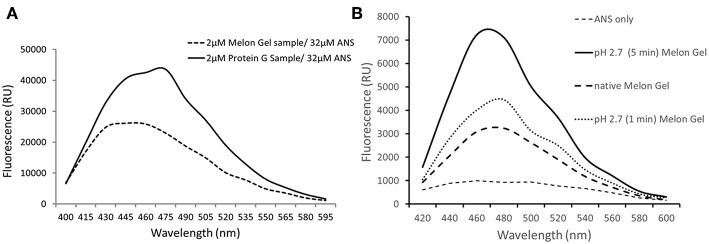
(A) Emission spectra of 32 μM ANS in the presence of 2 μM of a Protein G sample and a Melon Gel sample. (B) Emission spectra of 32 μM ANS in the presence of 2 μM of a native and pH 2.7 buffer exposed (5 min or 1 min) Melon gel sample.